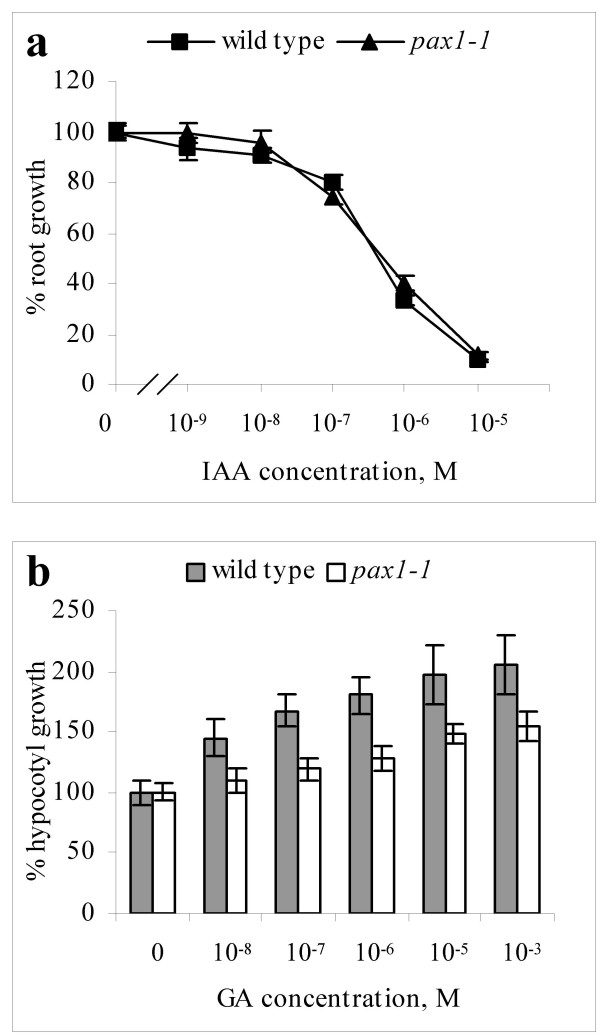
pax1-1 hormone responses. (a) Root growth response to exogenous IAA. n ≥ 13. (b) Hypocotyl growth response to exogenous GA3. n ≥ 14. The amount of growth is expressed as percentage growth relative to untreated controls. Error bars represent SE.